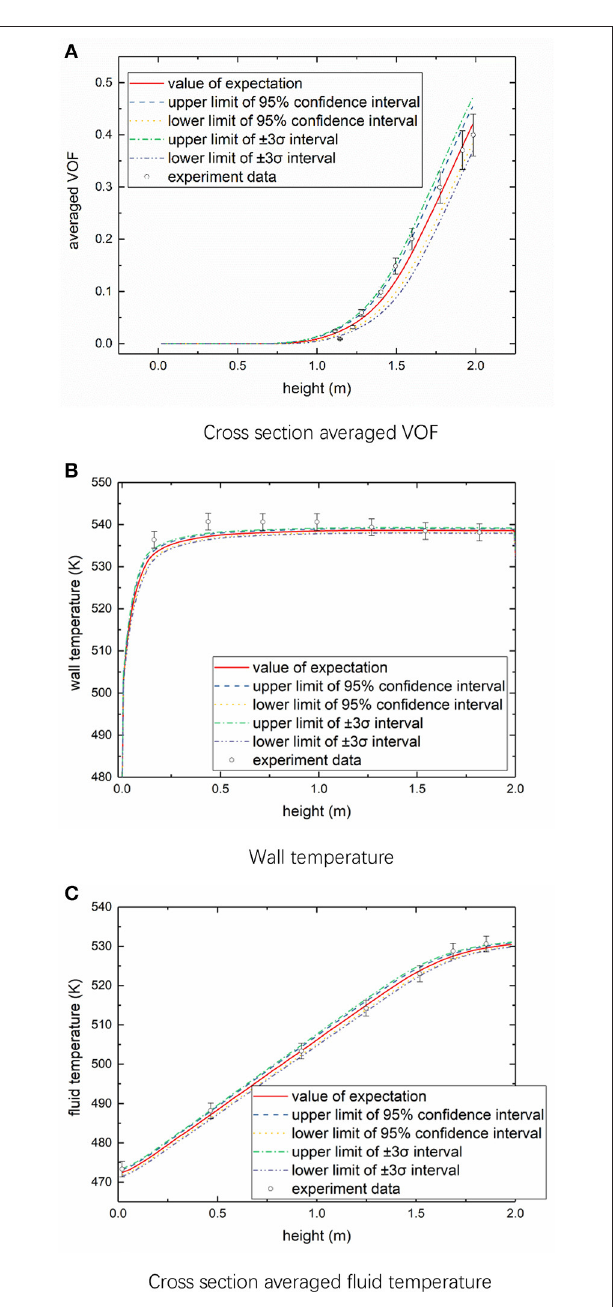
FIGURE 4 | Value of expectation, 95% confidence interval and (A) Cross section averaged VOF. (B) Wall temperature. (C) Cross section averaged fluid